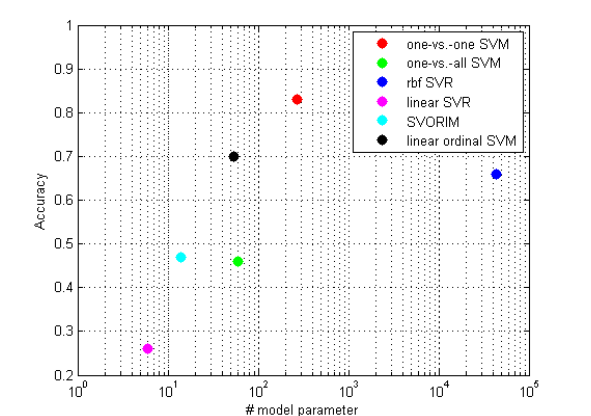
Figure 12: Accuracy related to model size at the example of the barley data